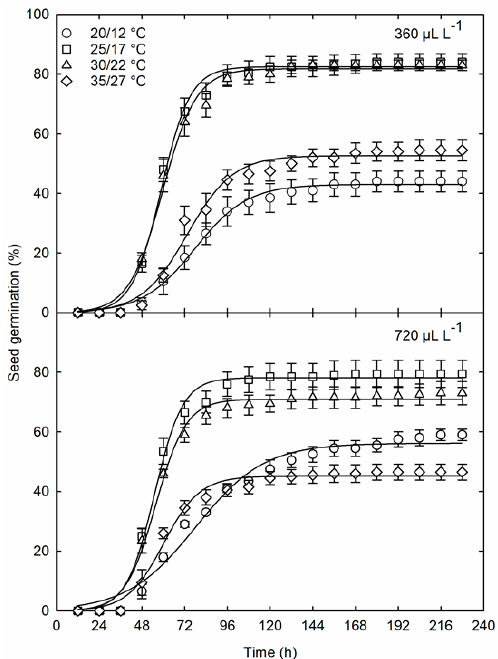
Figure 2. Germination time courses of eight parental environments when averaged across a range of germination temperatures (10–42.5 °C). Lines fitted through a three-parameter sigmoidal curve represent germination time course, and symbols represent germination data. Data are means ± standard error (SE) of four plants ( n = 4) harvested from a given SPAR unit and used as replicates in statistical analysis for a respective parental environment.